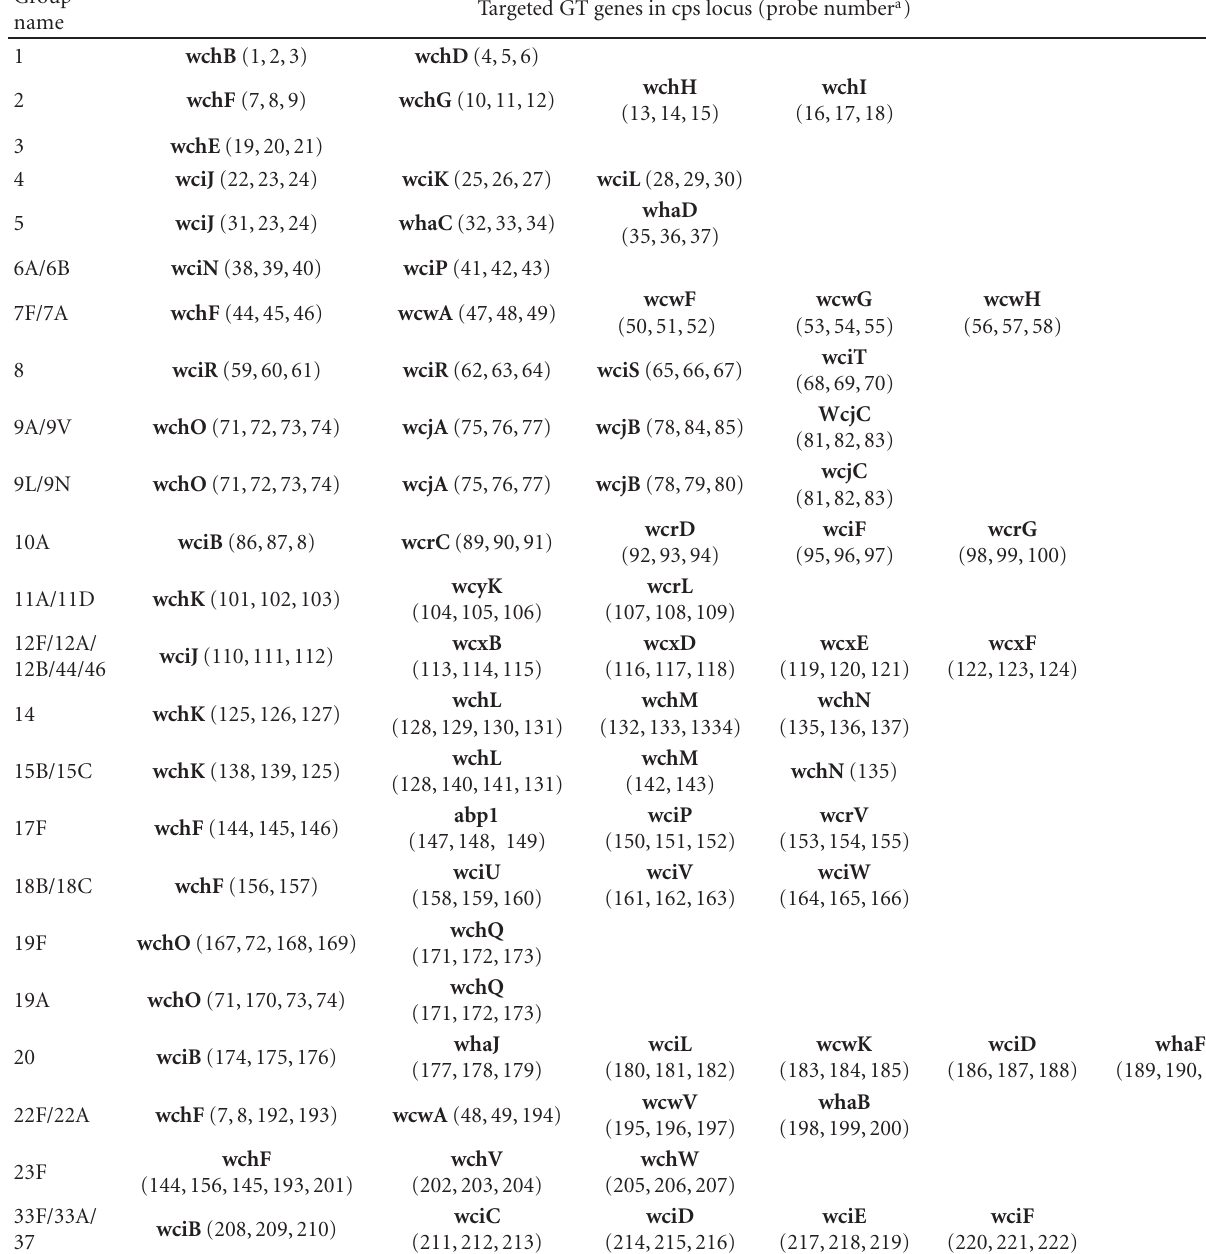
Table 2: Twenty-three groups distinguished in this study and targeted glycosyltransferase genes.